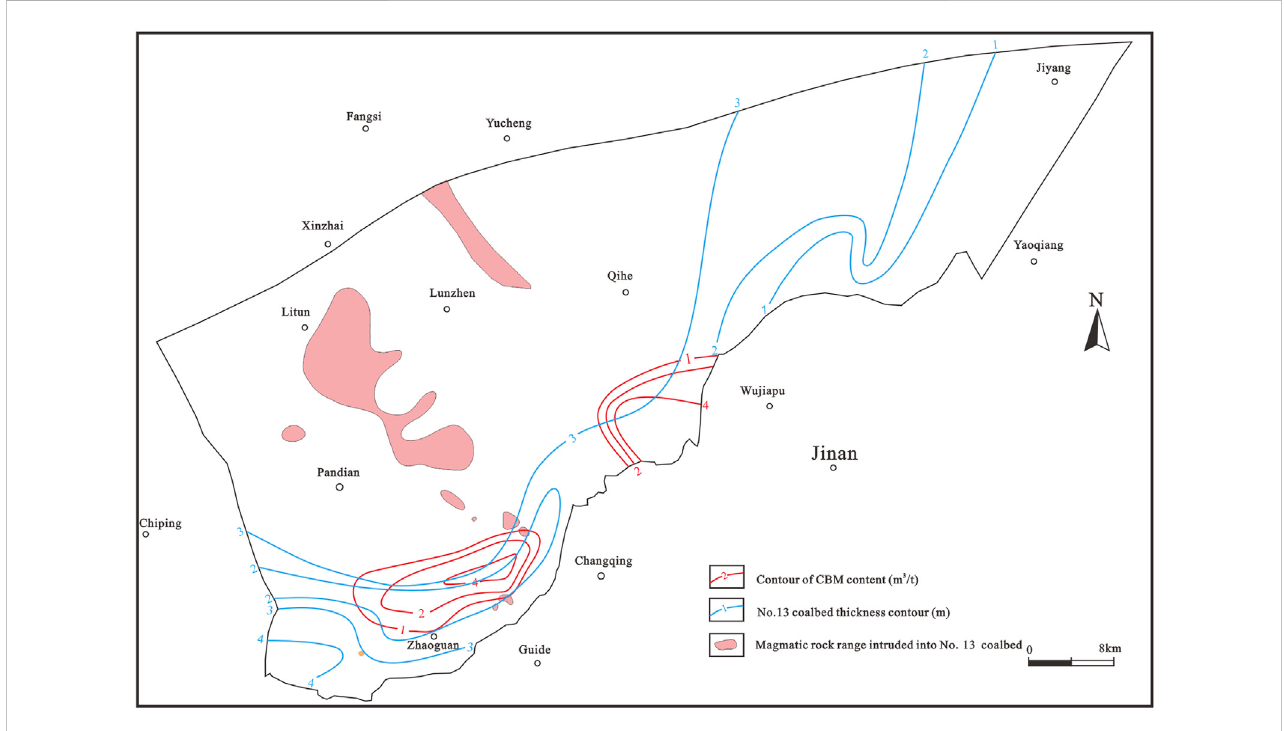
FIGURE 3 No. 13 coalbed thickness and gas content